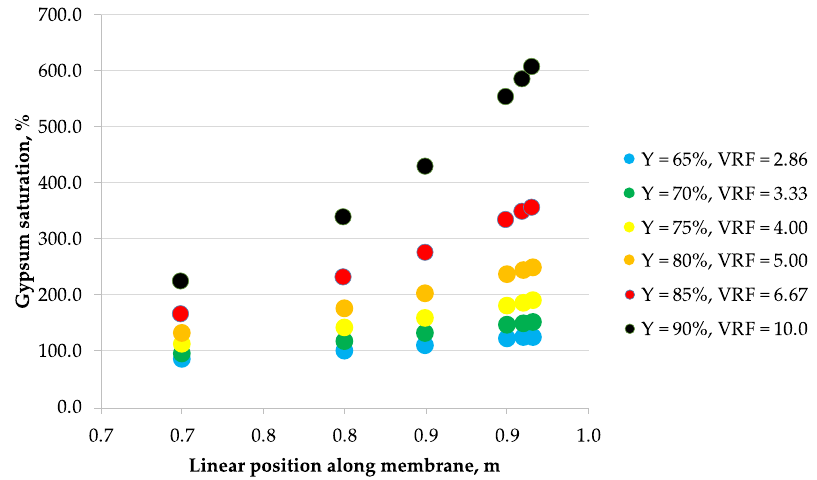
Figure 2. Saturation vs. position along the membrane for mine water A (0.384 g / L as Cl − , 1.02 g / L as SO 42 − , 0.107 g / L as Na + , 0.142 g / L as Mg 2 + , 0.312 g / L as Ca 2 + ) and NF270 nanofiltration membrane.